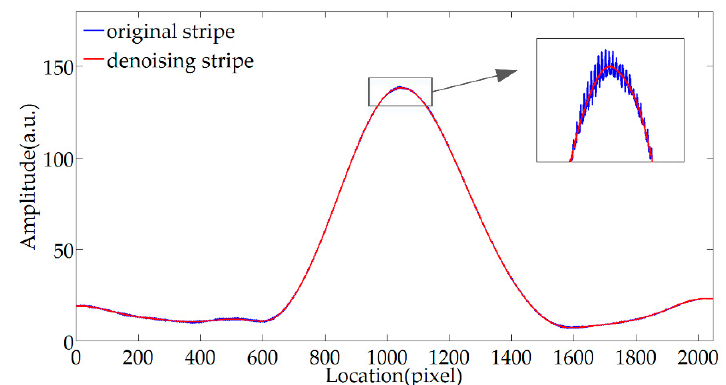
Figure 10. Complex Morlet envelope extraction effect before and after wavelet threshold denoising (WTD).